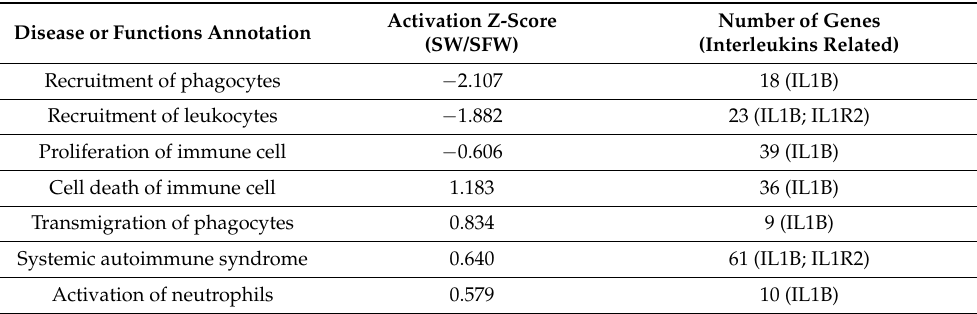
Table 1. IPA analysis (disease and bio-function) of the DEGs in gill upon hypo-osmotic stress. Selected terms were